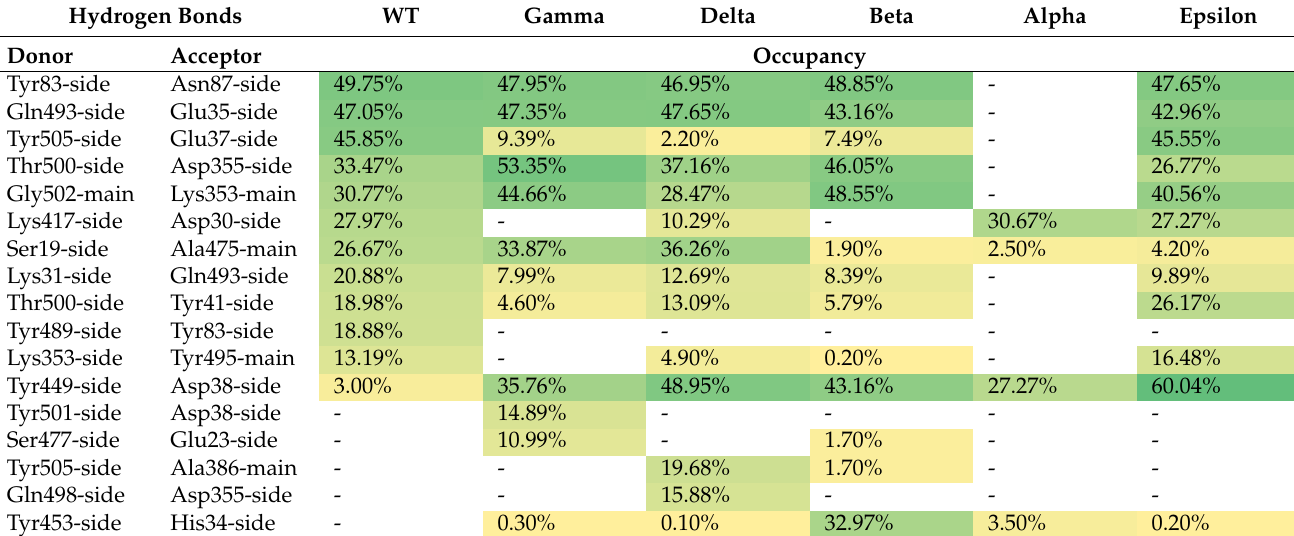
Table 3. Hydrogen-bond stabilities during the 100-ns MD simulation of S–hACE2 complexes.